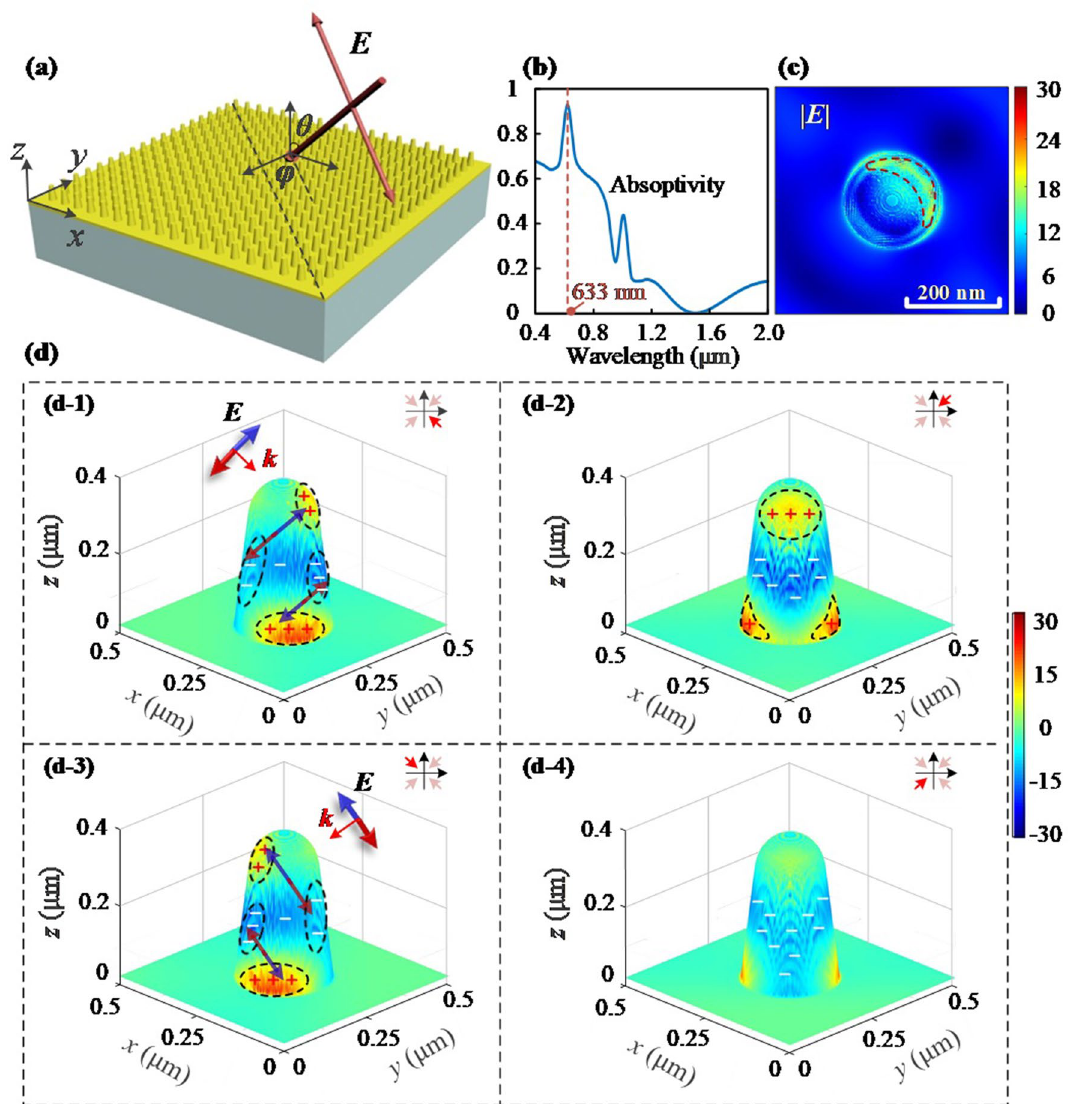
Figure 4. Simulated surface net charge distribution of GGNCT-III. ( a ) Schematic diagram of the simulation model with an incident angle of θ and the polarization angle of φ . ( b ) The simulated absorption spectrum in a wavelength range of 0.4–2 μm. ( c ) The top view about the distribution of the electric field intensity | E |. ( d ) Several typical 3D presentations about the surface net charge distribution according to different perspectives at − 45°, 45°, 135°, and − 135°, are exhibited in ( d-1 )–( d-4 ). Several small regions colored red and blue are filled by the net positive and negative charges, respectively. A detailed arrangement of a dipole of net charges over the sidewall of the GGNCT excited by the incident polarized light vector E labeled by an